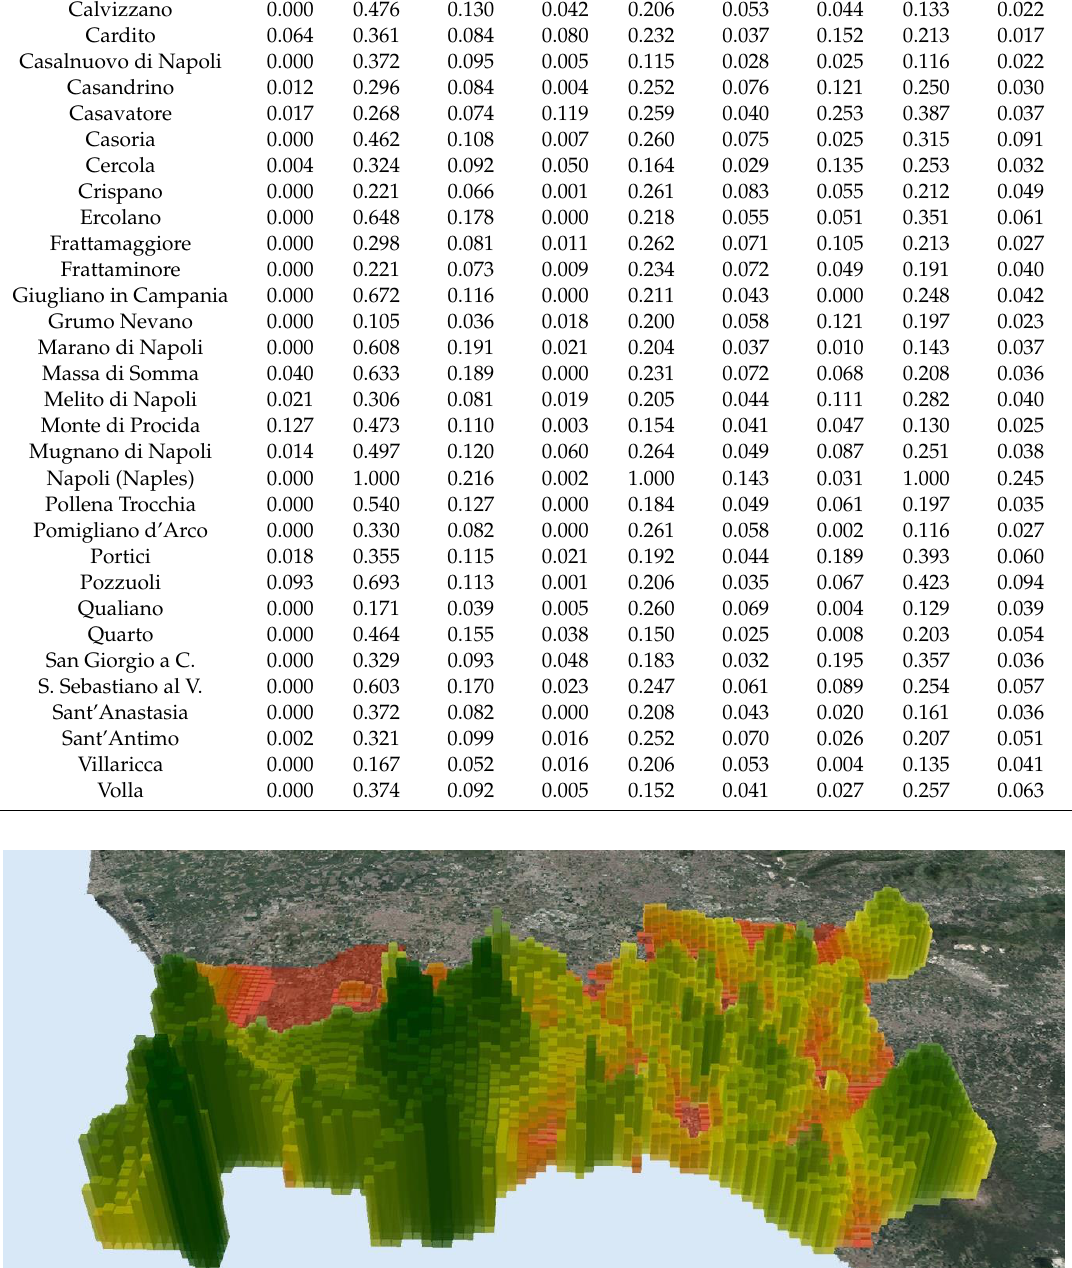
Figure 7. 3D visualisation of Carrier Services values with Jenks natural breaks categorisation. The colour gradient and histogram height show high (green) and low (red) UES values. Figure 8 highlights the comparison among the UES values per function by overlapping the z- values of the grid. The three coloured gradients represent Regulation (green), Carrier (blue), and Information (red) services. The north-eastern areas showed low values (or a lack of them) for Carrier and Information functions, while moderate values for Regulation functions balanced this gap. The null values in the north-western regions of the focus area can be attributed to the absence of services and the information gap.